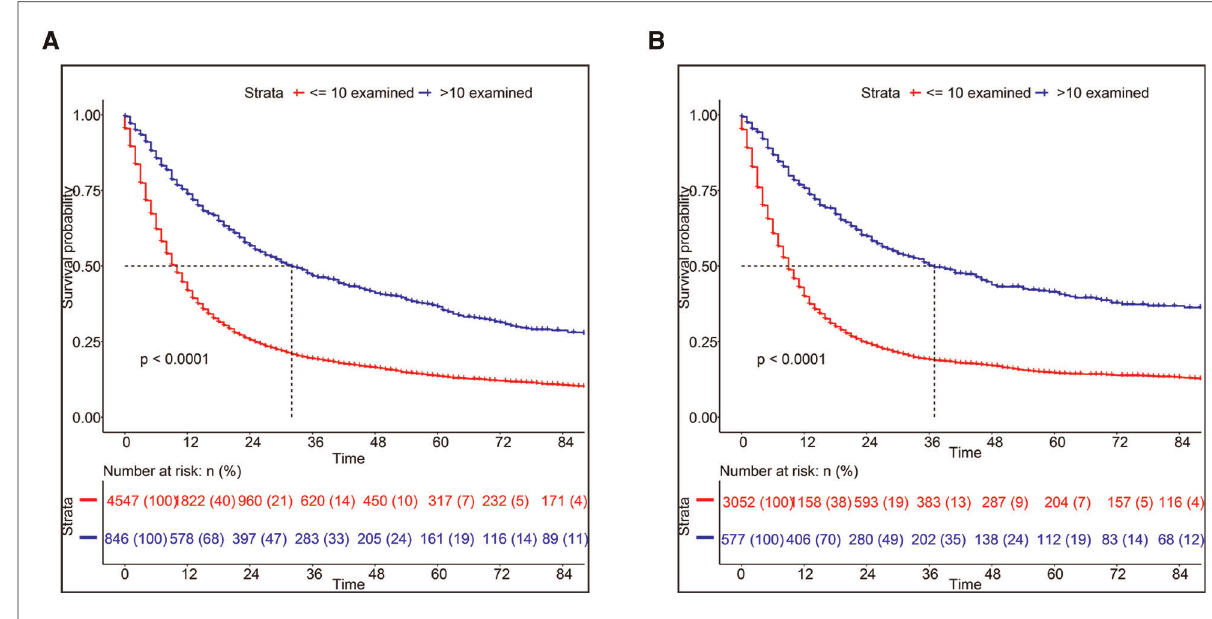
FIGURE 1 Kaplan-Meier survival analysis based on the number of ELNs. ( A ) OS, ( B )